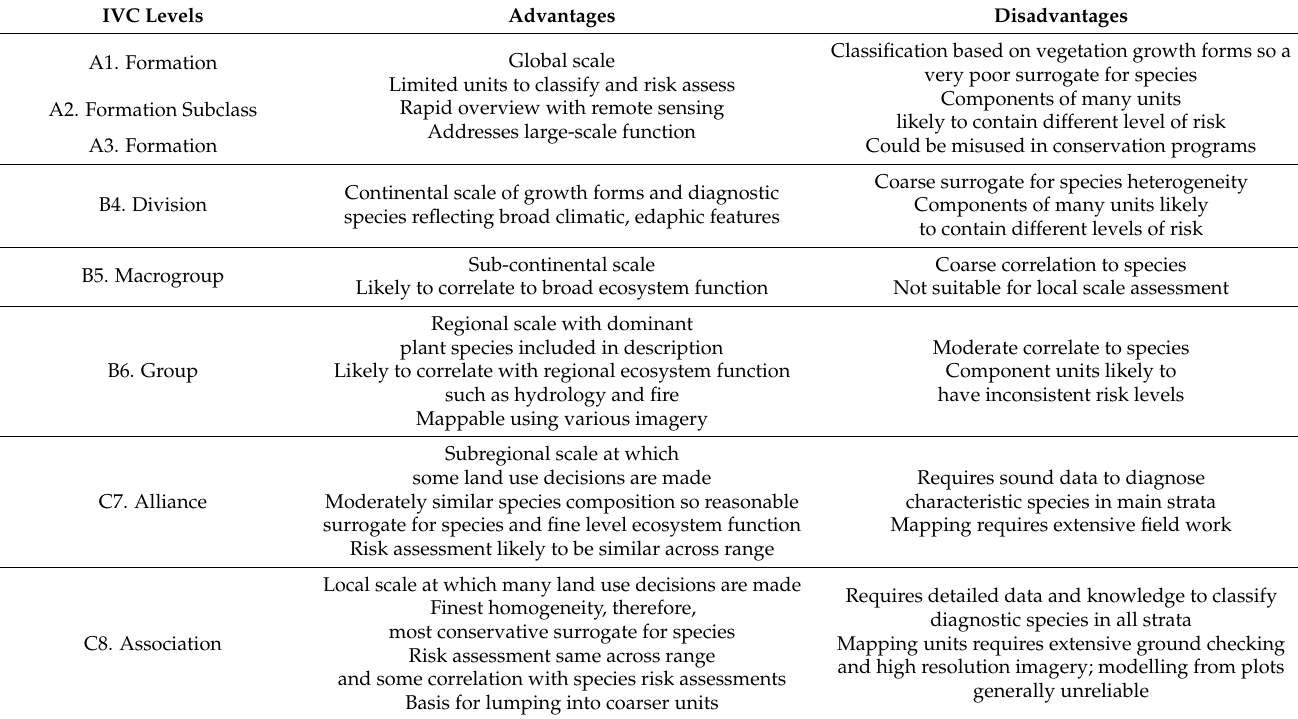
Table 3. Advantages and disadvantages of applying risk assessment to the International Vegetation Classification [12]: A = upper levels, B = middle levels, C = lower